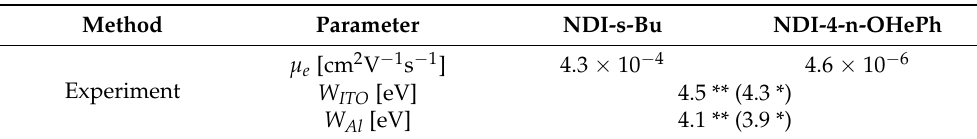
Table 3. Experimentally determined electron mobility for NDI-s-Bu and for NDI-4-n-OHePh and work function of ITO and Al